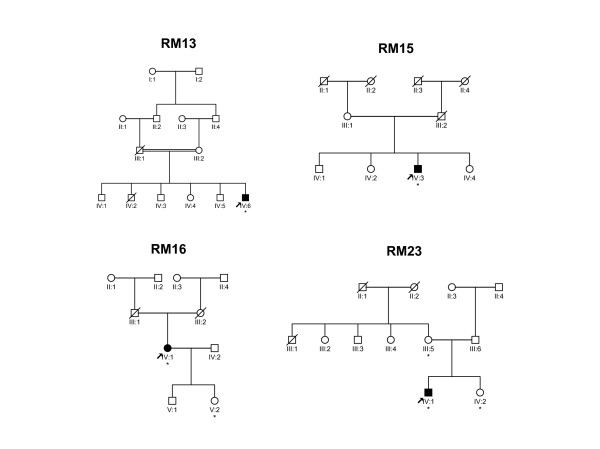
Pedigrees of families RM13, RM15, RM16, and RM23. Black squares (males) and circles (females) indicate individuals affected with NA. Unaffected individuals are not shaded. Diagonal slashes represent deceased individuals. * Indicates individuals with acanthocytosis and the selective alteration of the 4.1R protein of the erythrocyte membrane.